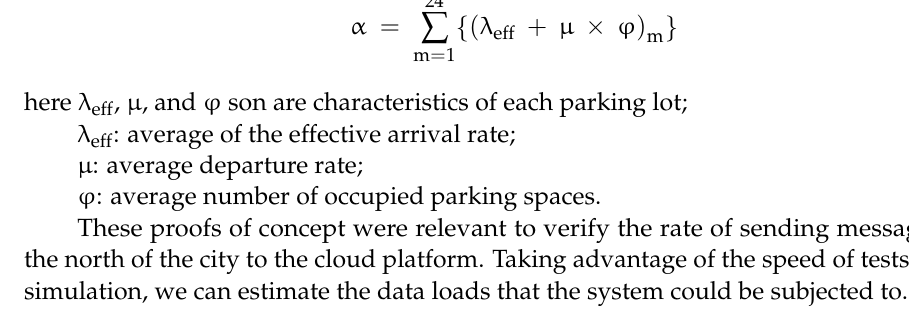
Table 15. Real-time simulation of the operation of the parking lots in the north of Madrid.